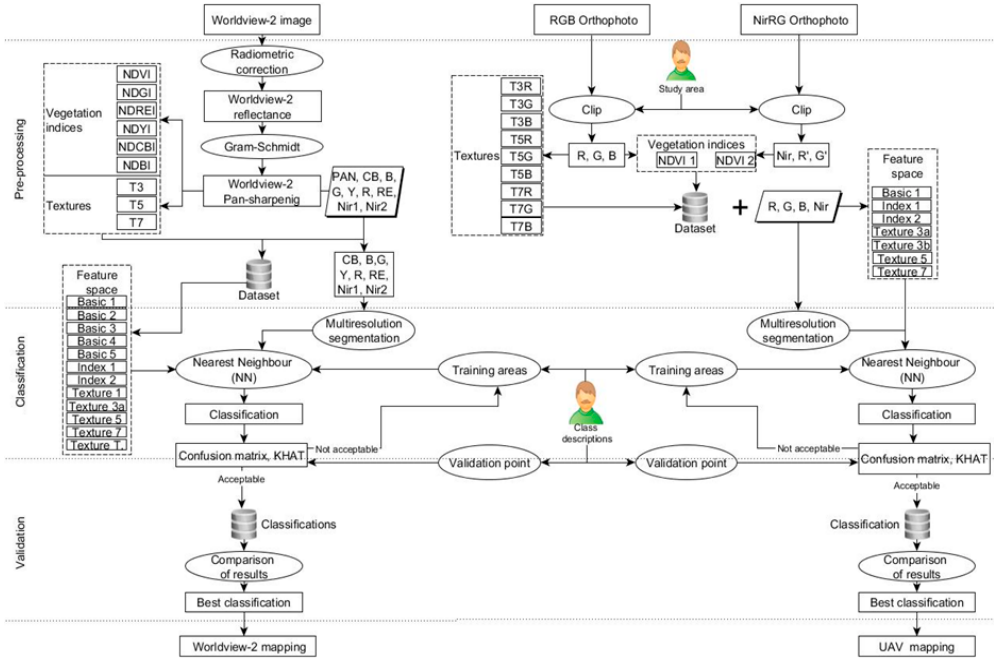
Figure 2. Summary of the workflow followed in this research. The processes are in circles, and the outputs in